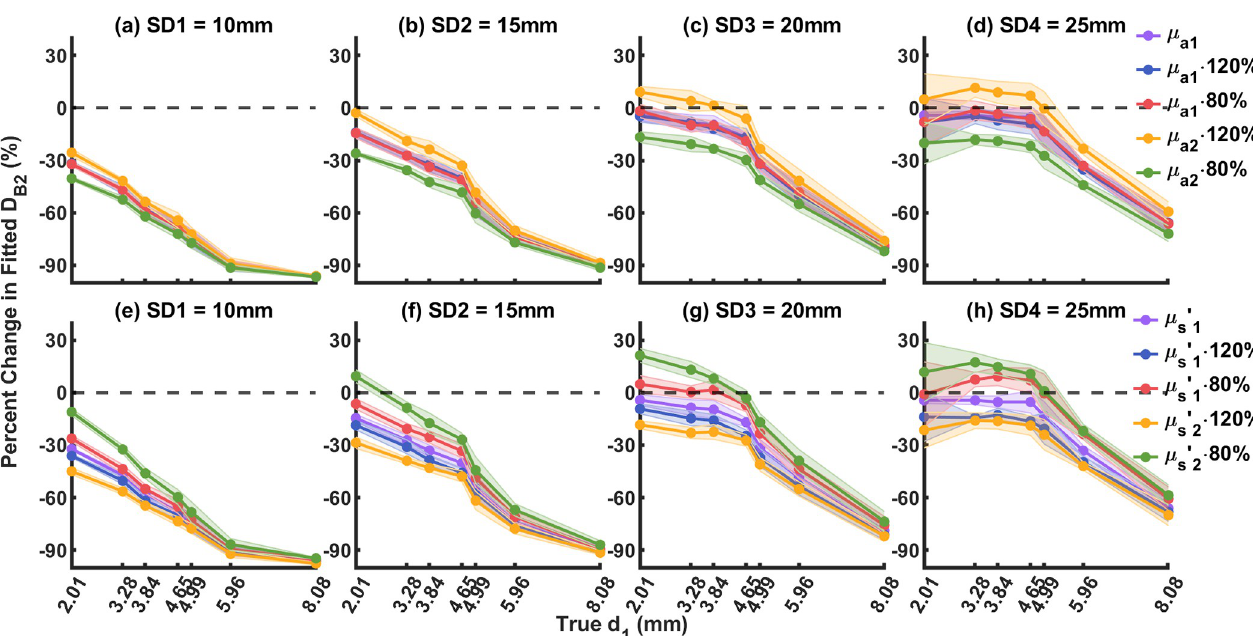
Fig 10. Influence of uncertainties in layer optical properties on fitted D B2 . Purple: baseline. Blue: first layer increased by 20%. Red: first layer decreased by 20%. Yellow: second layer increased by 20%. Green: second layer decreased by 20%. (a-d) Influence of layer μ